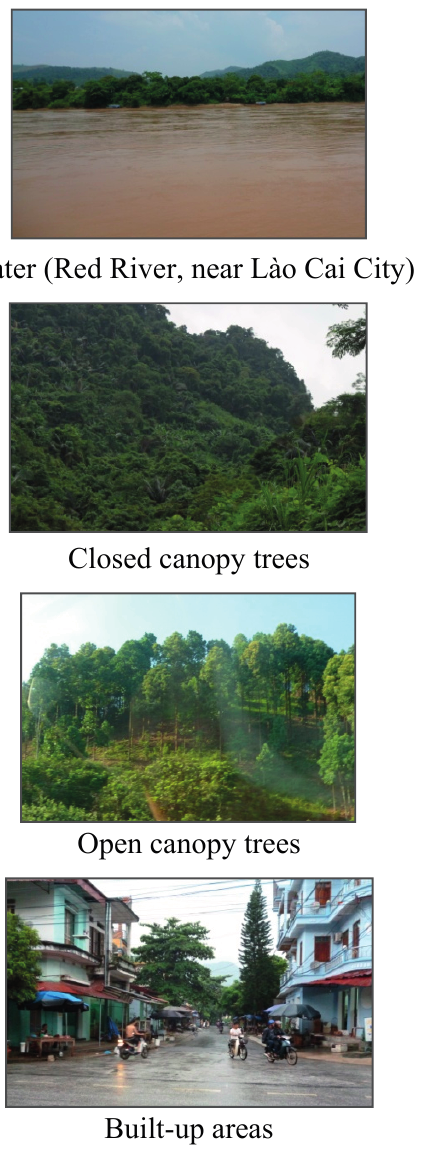
Figure 2. Illustration of the six LULC classes. (Photo credit: Lê M ạ nh An, Thi-Thanh-Hiên Pham). Segmentation parameters in eCognition (bands, scales, color/shape ratio, and compactness/smoothness ratio) were tested at different values. Segmentations and rule-based classifications were undertaken at different scales using the same band composition (bands 1–5, 7), color/shape ratio (0.2/0.8),